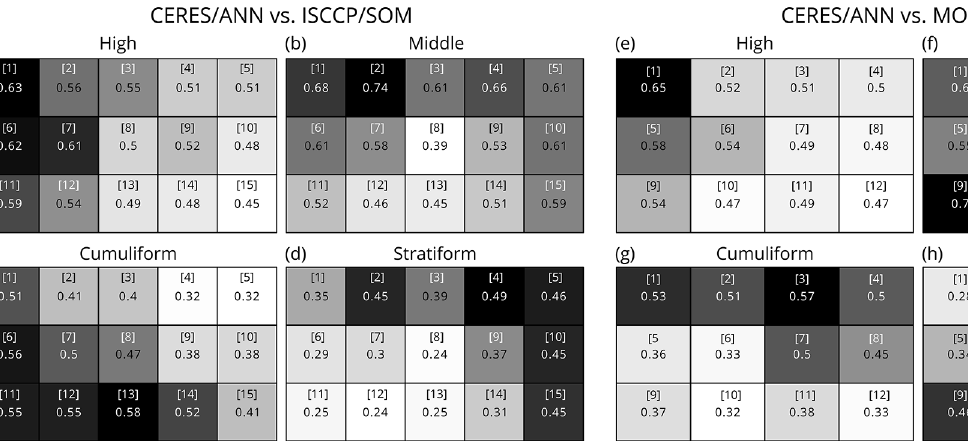
Table B1. Comparison of the co-occurrence of our ANN-derived cloud types (CERES/ANN) with SOM-derived cloud clusters (ISCCP/- SOM and MODIS/SOM) of McDonald and Parsons (2018) and Schuddeboom et al. (2018), respectively. The grids in panels (a–d) and (e–h) represent our four ANN-derived cloud types (high, middle, cumuliform and stratiform). The grid boxes in each subplot correspond to the SOM-derived cloud clusters of the past studies. Numbers in square brackets in the boxes are the ISCCP/SOM and MODIS/SOM cluster numbers as in the original studies. Numbers in the centres of the boxes and box shading are the co-occurrence (scale 0–1) of the ANN- derived cloud type and the SOM-derived cloud cluster. The co-occurrence is calculated from 1 year (2007) of daily mean values on a global spatial grid. Note that the definition of the ISCCP/SOM and MODIS/SOM clusters is different, and therefore panels (a–d) and (e–h) are not expected to be